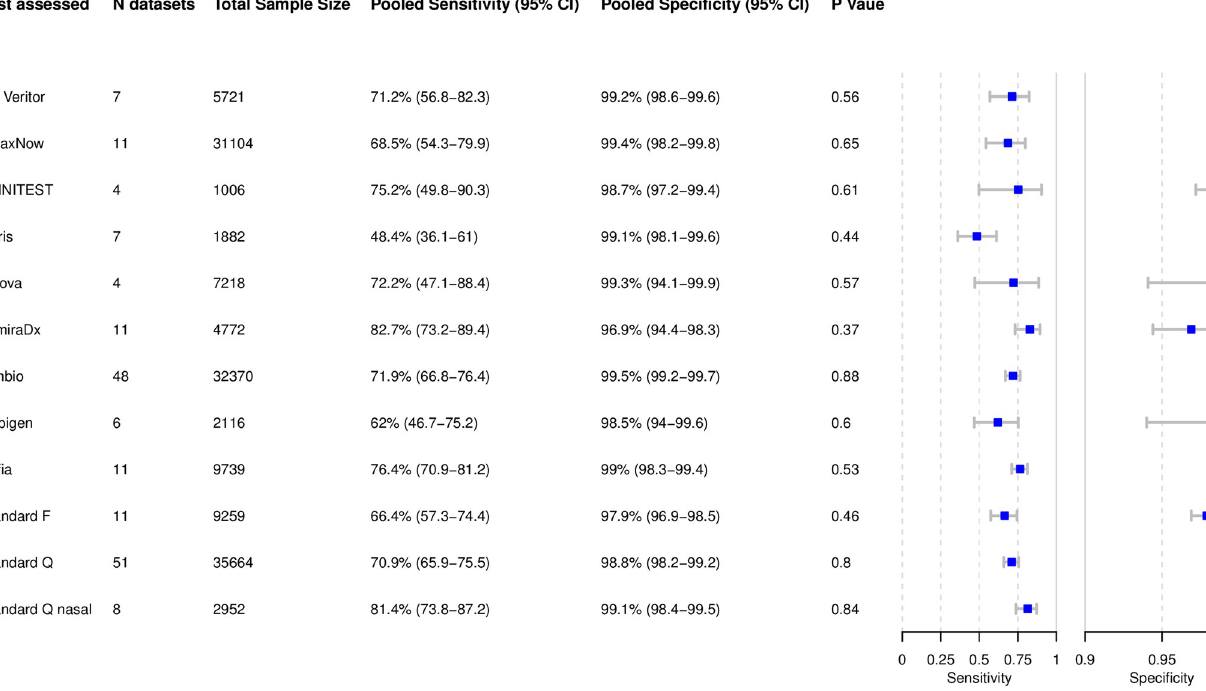
PLOS Medicine| https://doi.org/10.1371/journal.pmed.1004011 May 26,